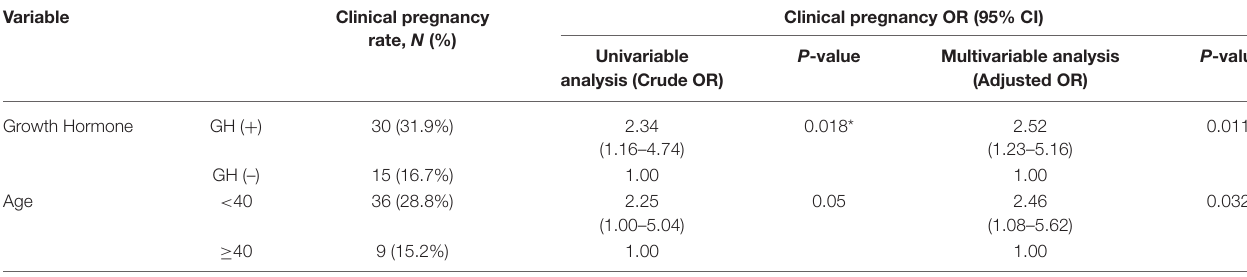
TABLE 2 | Logistic regression with univariate and multivariate analysis of the pregnancy outcome for poor-responders. Variable Clinical pregnancy